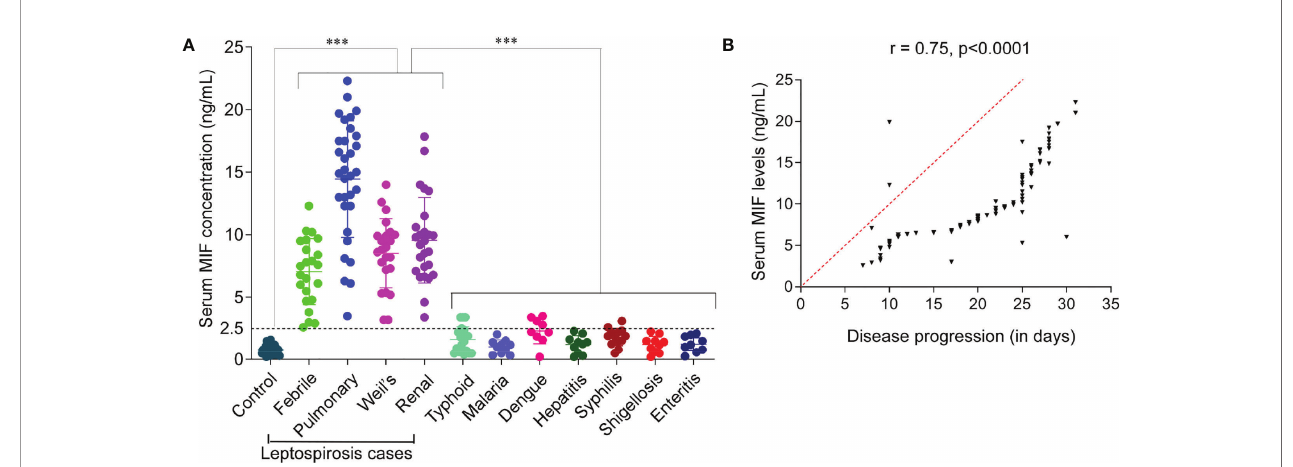
FIGURE 1 | Serum macrophage migration inhibitory factor (MIF) pro fi ling and analysis of its diagnostic value for the early diagnosis of leptospirosis. (A) Pro fi ling of MIF in sera of patients with leptospirosis with different clinical manifestations, other febrile illnesses, and healthy controls. Study groups are indicated on the x -axis and the MIF concentration on the y -axis. Dotted line represents the cutoff with the absolute values on the left . n = 3 experiments. *** p < 0.001. (B) Pearson ’ s correlation coef fi cients between serum MIF levels and disease progression. This analysis showed that serum MIF was positively correlated with disease progression, which indicates the contribution of serum MIF to disease severity ( r = 0.75, p < 0.0001), acting as a severity